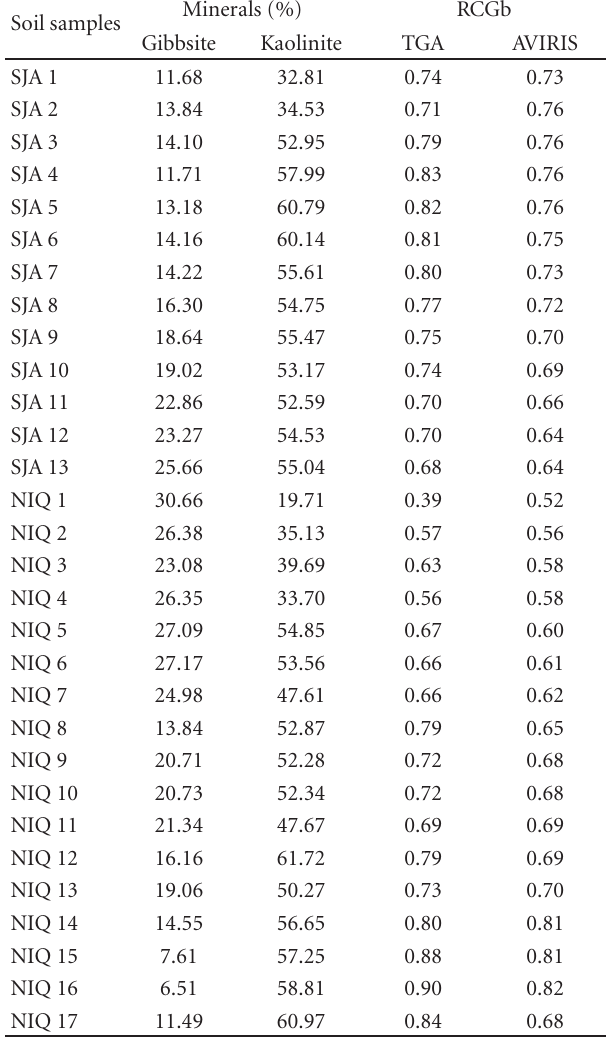
Table 1: RCGb obtained by means of TGA and AVIRIS data for samples collected in S˜ao Jo˜ao D’Alianc¸a (SJA) and in Niquelˆandia